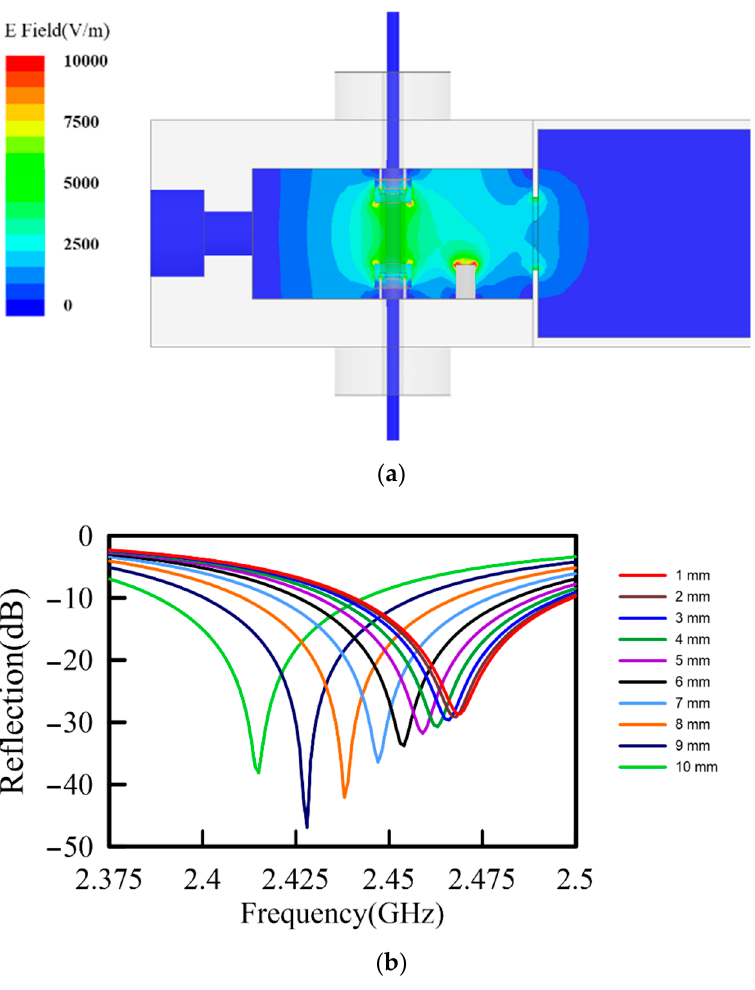
Figure 2. The simulation results of the TM-mode resonant cavity. ( a ) The distribution of E-field at microwave power of 20 W. ( b ) The frequency response of the cavity varied with the height of the tuner from 1 mm to 10 mm.